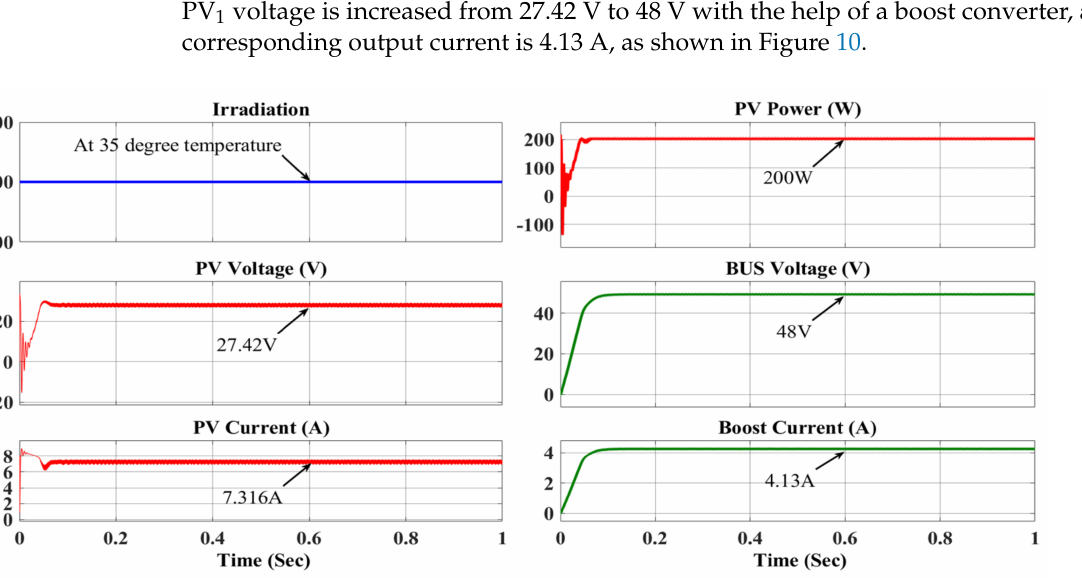
Figure 10. PV measurements, boost voltage, current, and PV output power at an irradiance of 600 W/m 2 and temperature of 35 ◦ C for PV 1